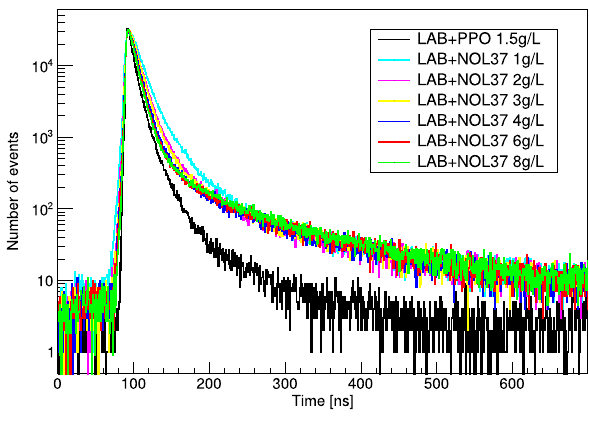
Fig. 6 Light emission kinetics of liquid scintillators with NOL 37